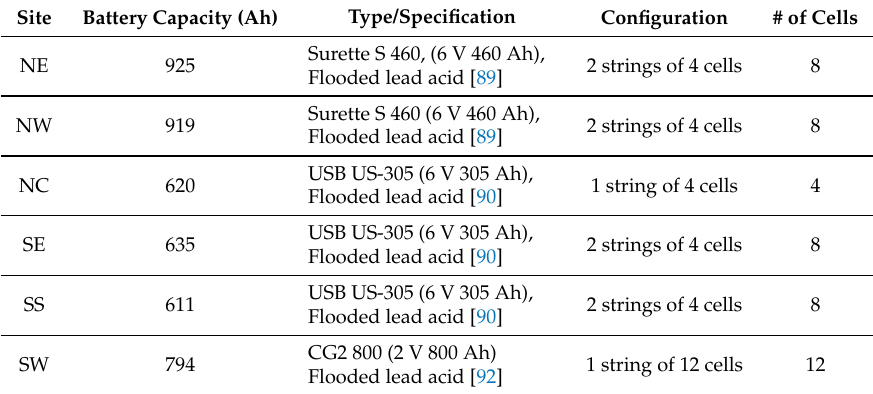
Table 5. Selected battery